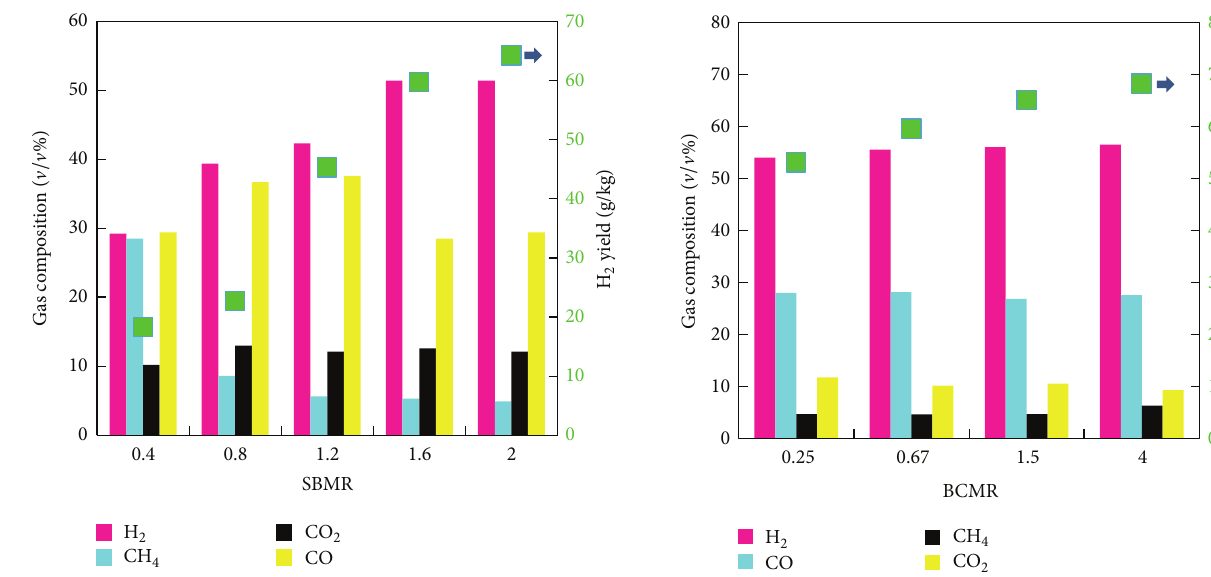
temperature range; thus the ( R 3) and ( R 4) reactions have a more prevailing role.